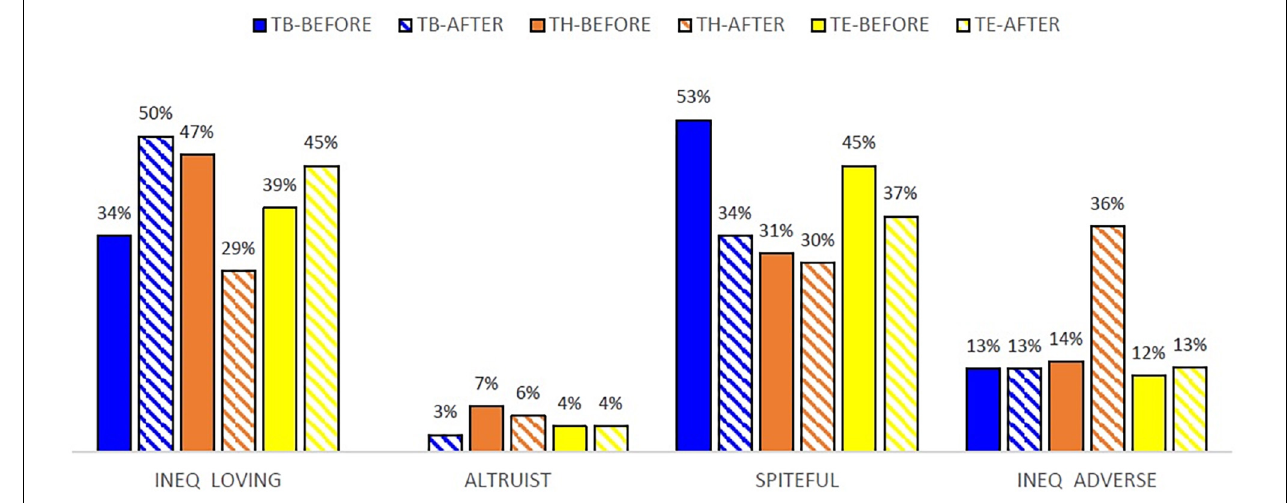
FIGURE 3 | Frequency of EET archetypes before and after the TG, per treatment.